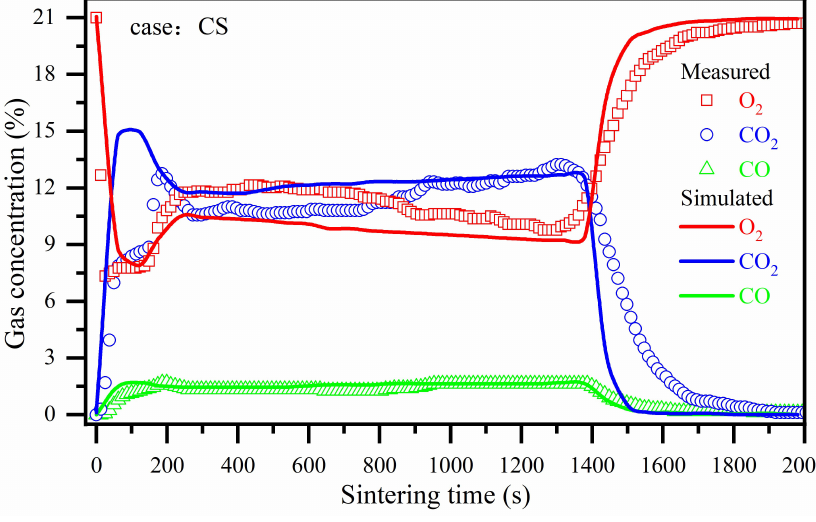
Figure 4. Comparison of simulated and measured values of the main components of flue